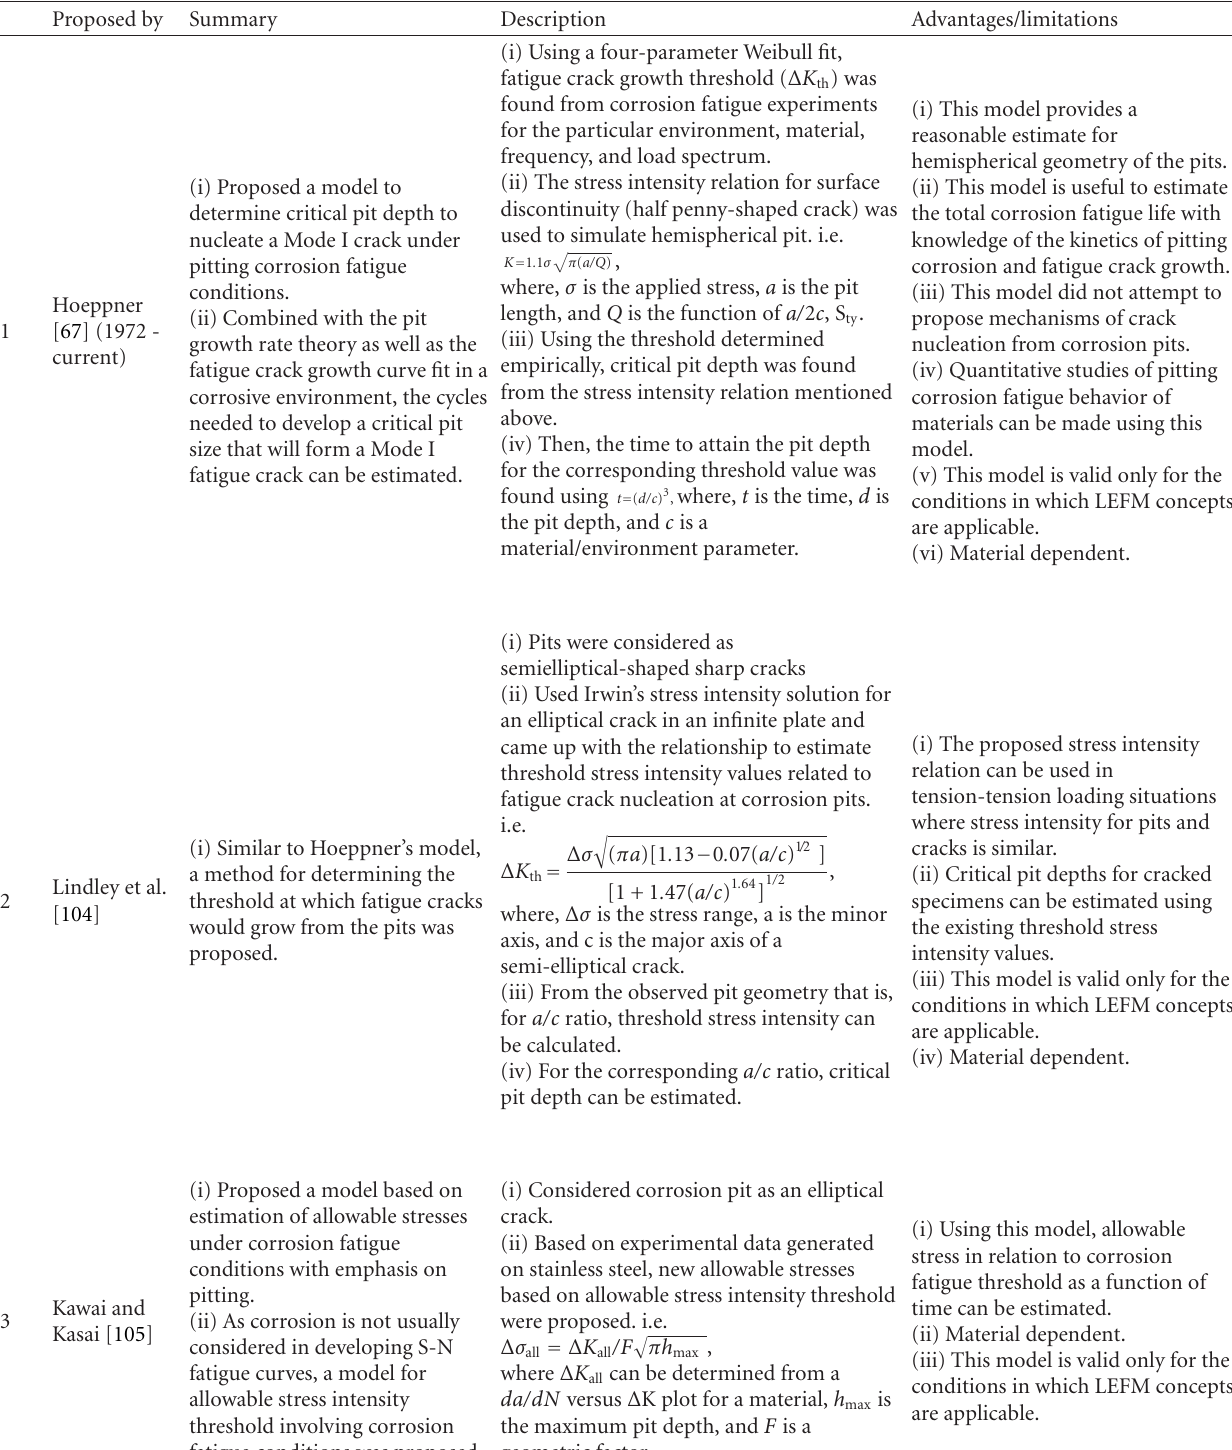
Table 8: Pitting corrosion fatigue models background-references [112, 113,